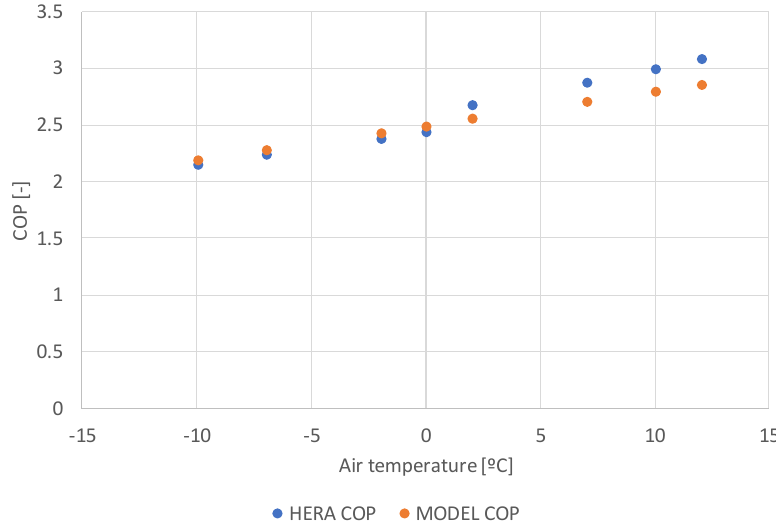
Figure 7. Comparison between the coefficient of performance (COP) obtained with the model and the COP of HERA 190-2-2 from EUROKLIMAT.